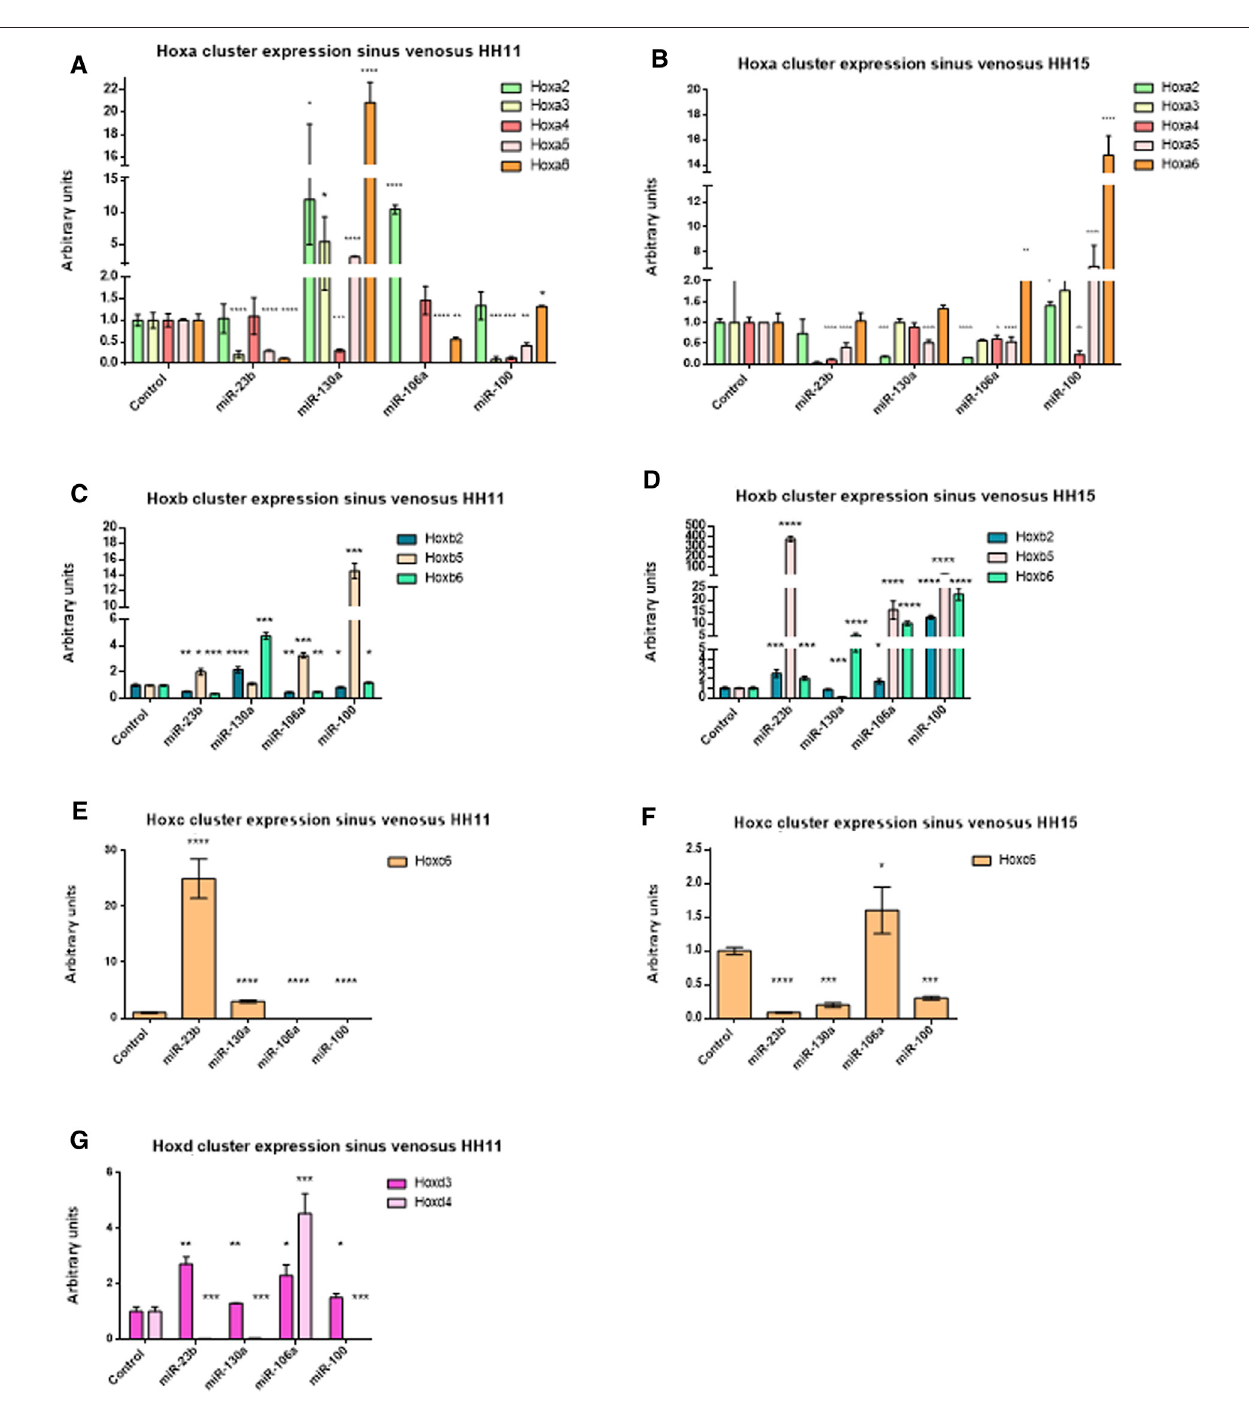
FIGURE6| qPCRanalysisoftheHoxaclusteratstageHH11 (A) andHH15 (B) ;HoxbclusteratstageHH11 (C) andHH15 (D) ;HoxcclusteratstageHH11 (E) and HH15 (F) , and Hoxd cluster at stage HH11 (G) gene expression in sinus venosus explants after miR-23b, miR-130a, miR-106a, and miR-100 gain-of-function assays illustrating signi fi cant up- and downregulation of these Hox genes. Student ’ s t -test: * p < 0.05, ** p < 0.01, *** p < 0.005, **** p < 0.001.